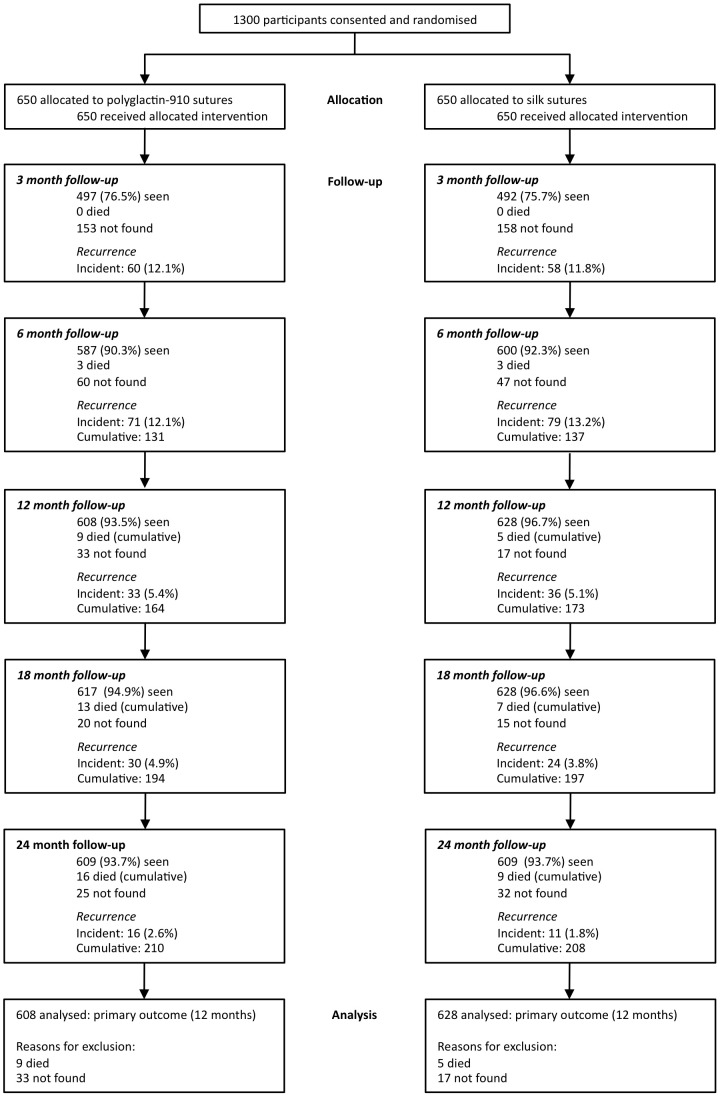
Consort flow chart 1.Absorbable versus silk sutures for surgical treatment of trachomatous trichiasis in ethiopia: a randomised controlled trial. PLoS Med 8: e1001137.